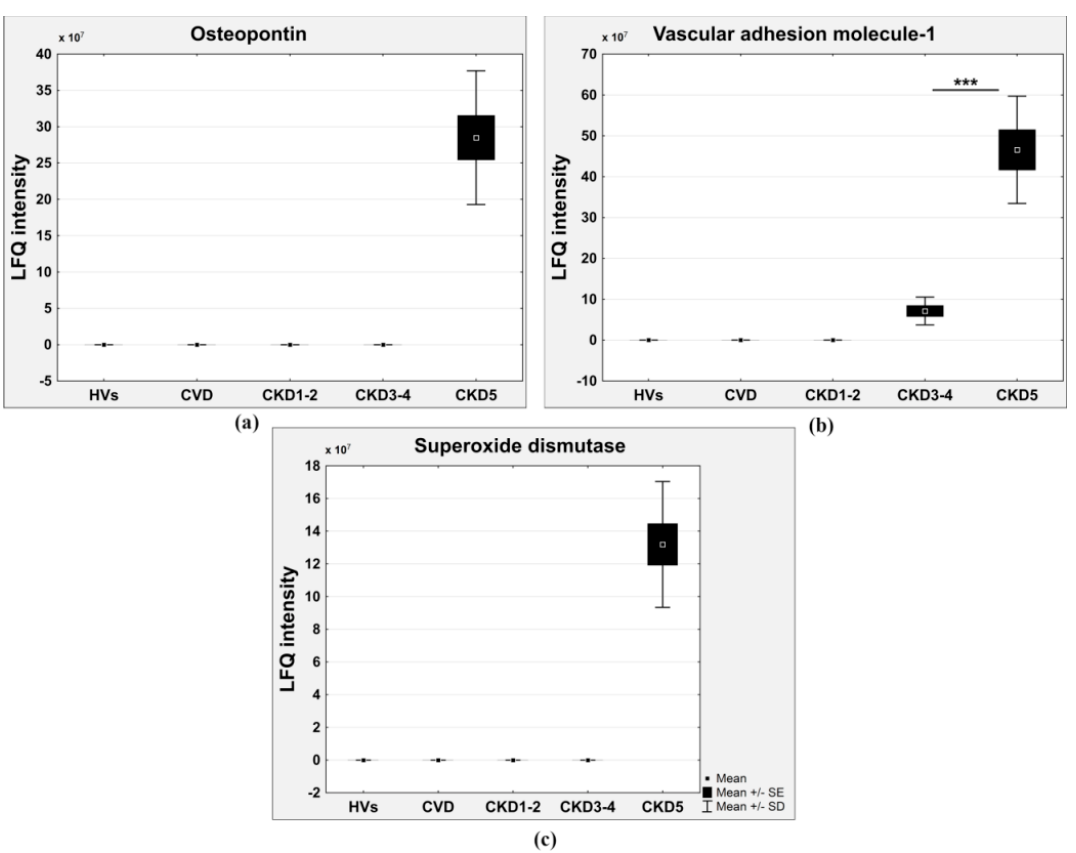
Figure 6. Relative abundance of osteopontin ( a ) VCAM1; ( b ) and superoxide dismutase; ( c ) in HVs, CKD1-2, CKD3-4, CKD5, and CVD groups. (*** p < 0.0001).